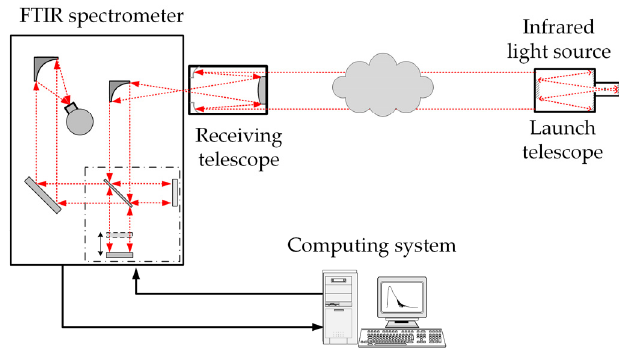
Figure 1. The working principle of the OP-FTIR.